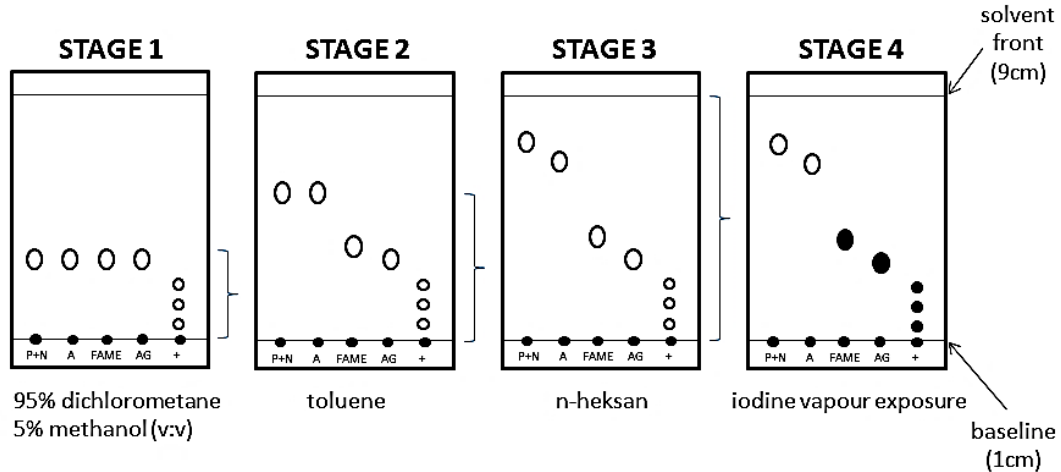
Figure 6. Schematic diagram of TLC chromatogram development for paraffins and naphthenes (P + N), Aromatic Hydrocarbons (A), FAME, acylglycerols (Tri- and Di-acylglycerols) (TAG + DAG) (AG), Natural originating enriching additives, dyes (+).